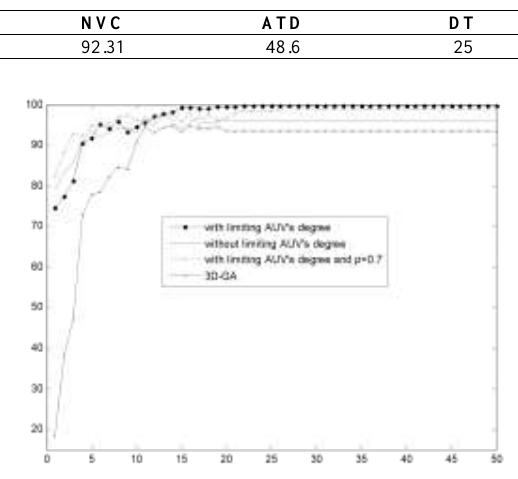
Table 6. Average of NVC, ATD and DT for 3D-GA.